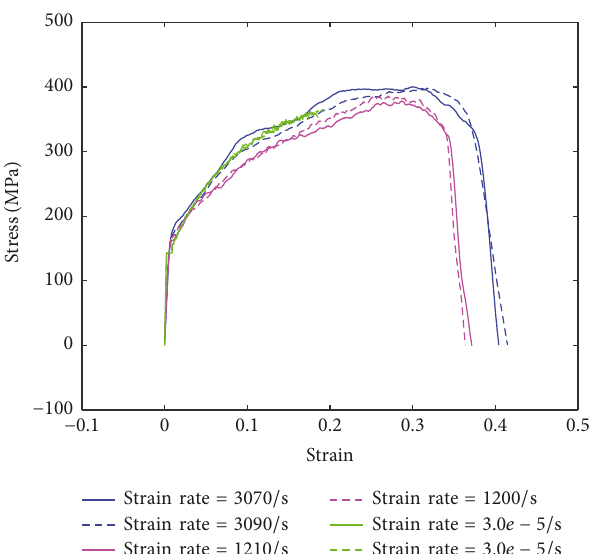
Figure 5: Stress-strain curves under static and dynamic loading.